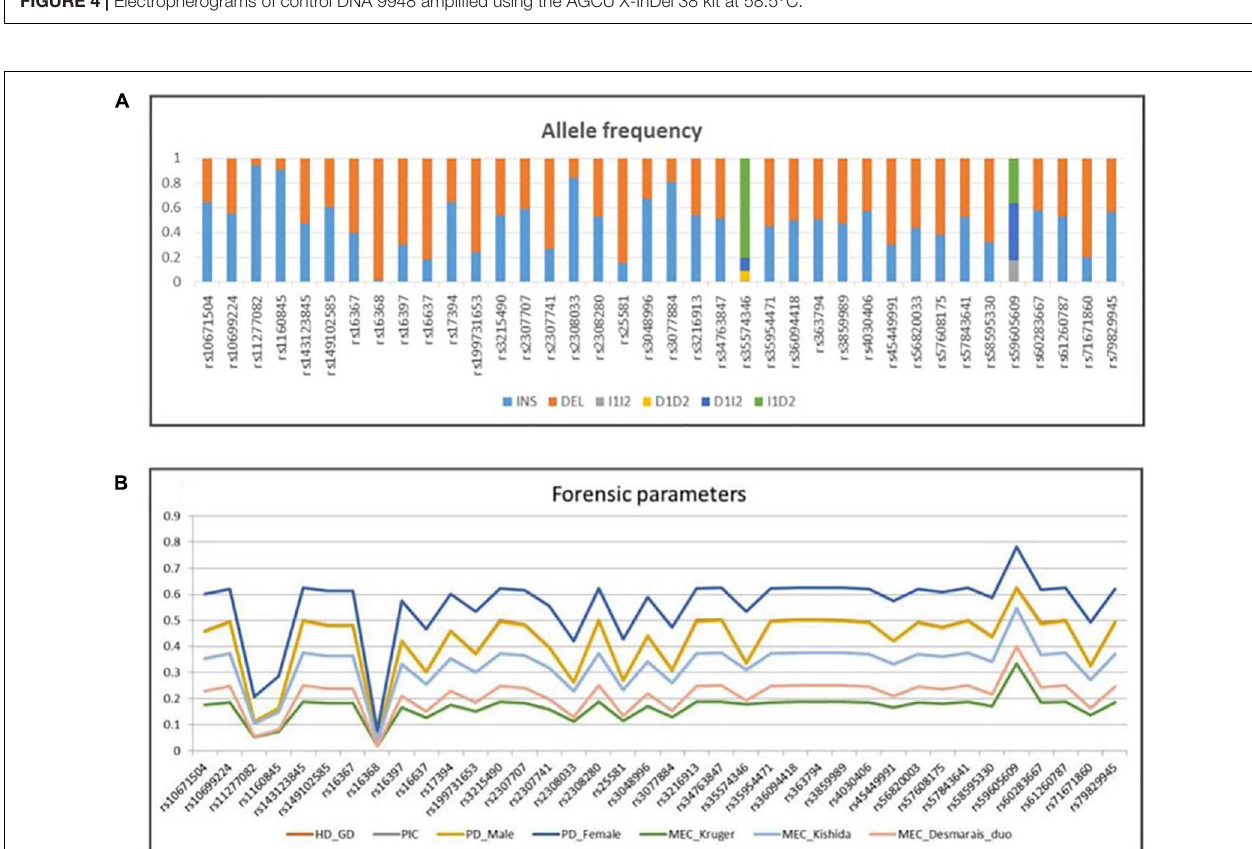
FIGURE 5 | (A) Allele frequency and (B) forensic parameters of 38 X-InDel loci in a group of 200 unrelated males from Guangdong Han population.